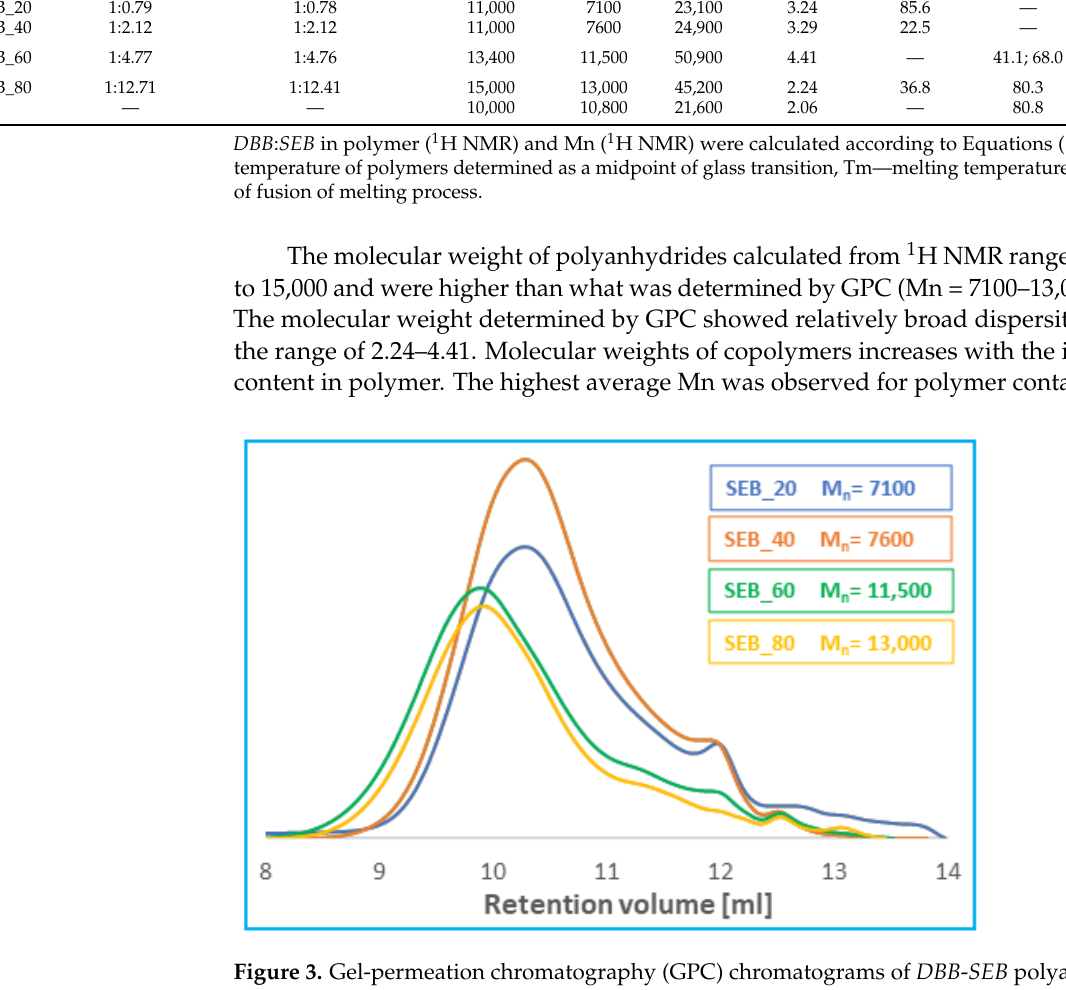
Table 3. Characteristics of DBB - SEB polyanhydrides.